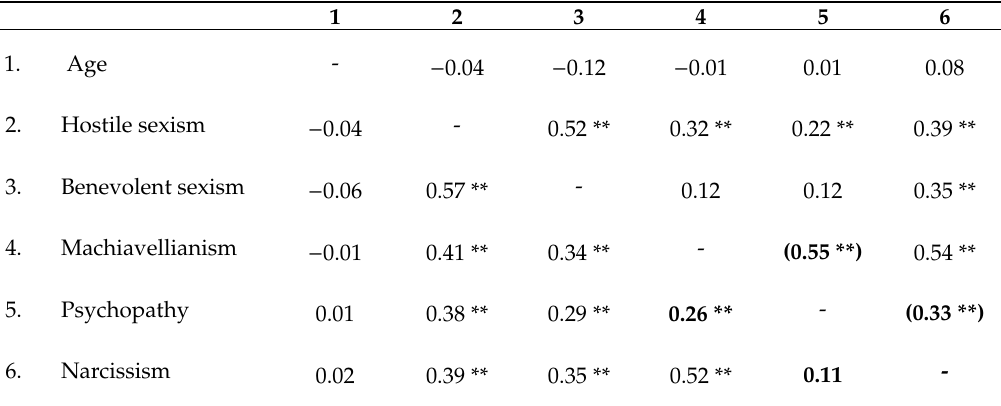
Table 2. Bivariate correlations between all of the study variables according to sex.